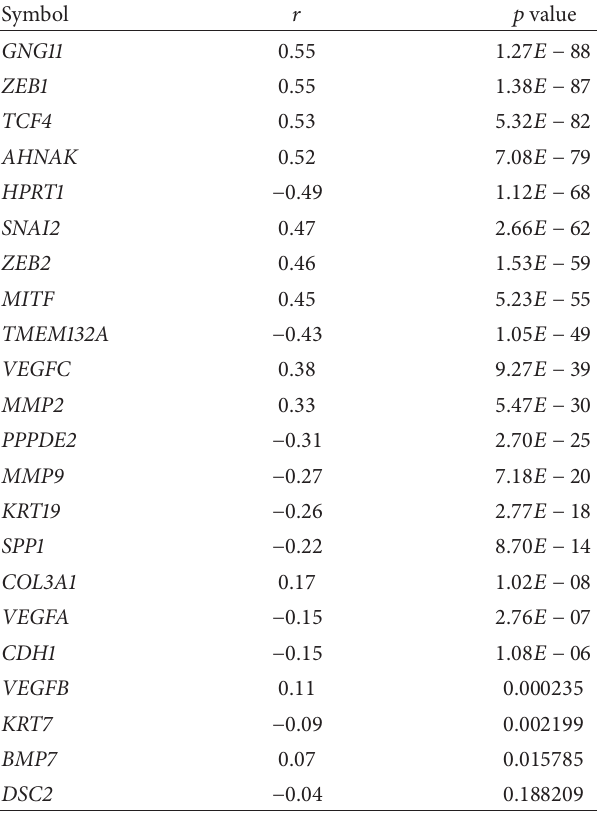
C10orf107, DONSON, CHAC1, and TUBA1C. Two more genes COL4A6 and CBX2 genes are in borderline to be sig- nificant. A summary of these 8 genes is listed in Table 6 and Figure